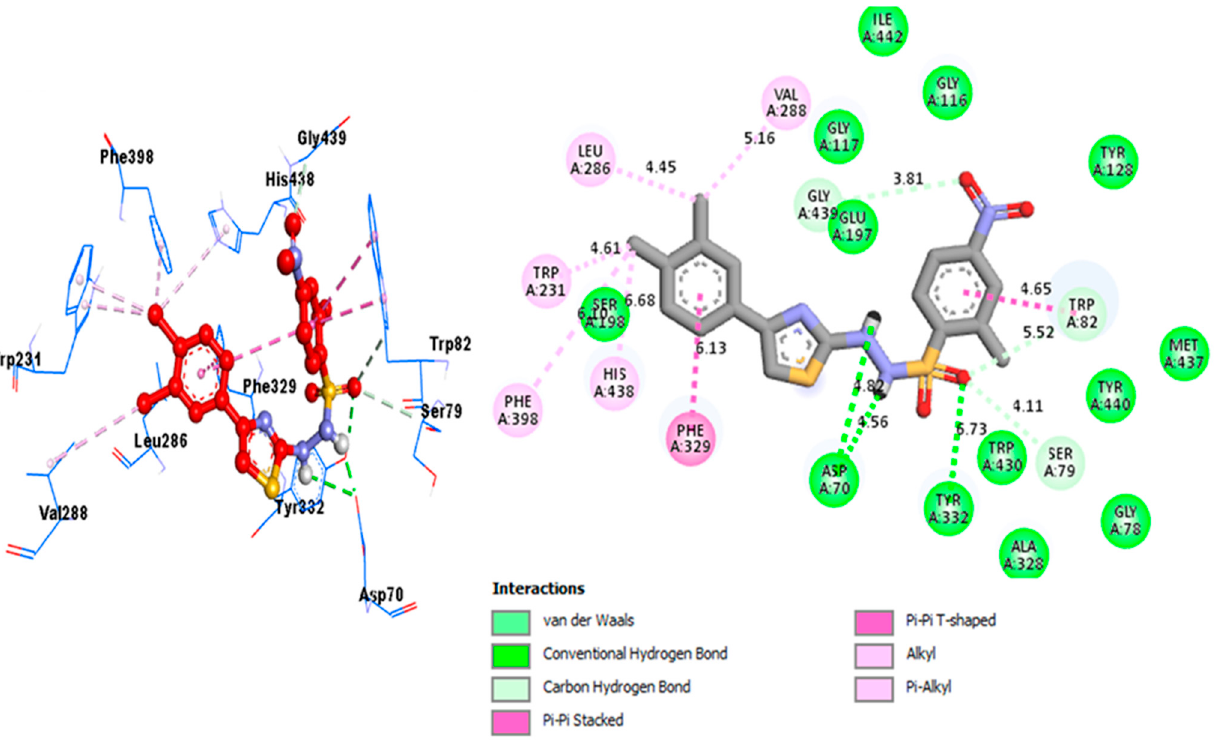
Figure 12. Representation of the PLI profile for compound 10 against BChE.